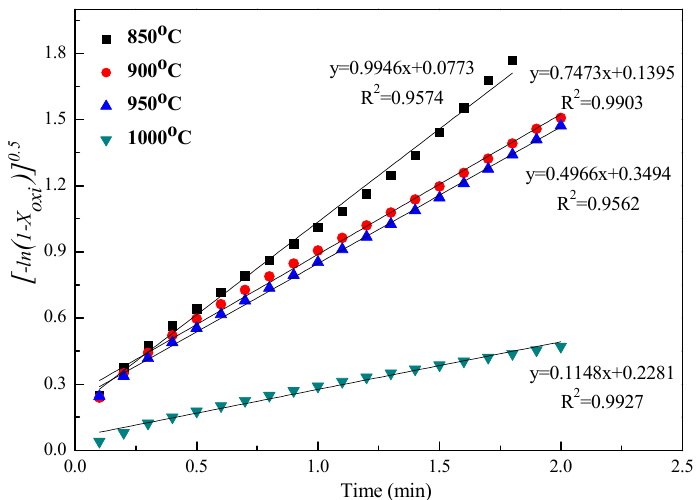
Figure 10. Kinetic regression results based on the Avrami-Erofey’ev (A2) model for the oxidation of decomposed CZ230-S1conducted with various temperatures under air atmosphere.